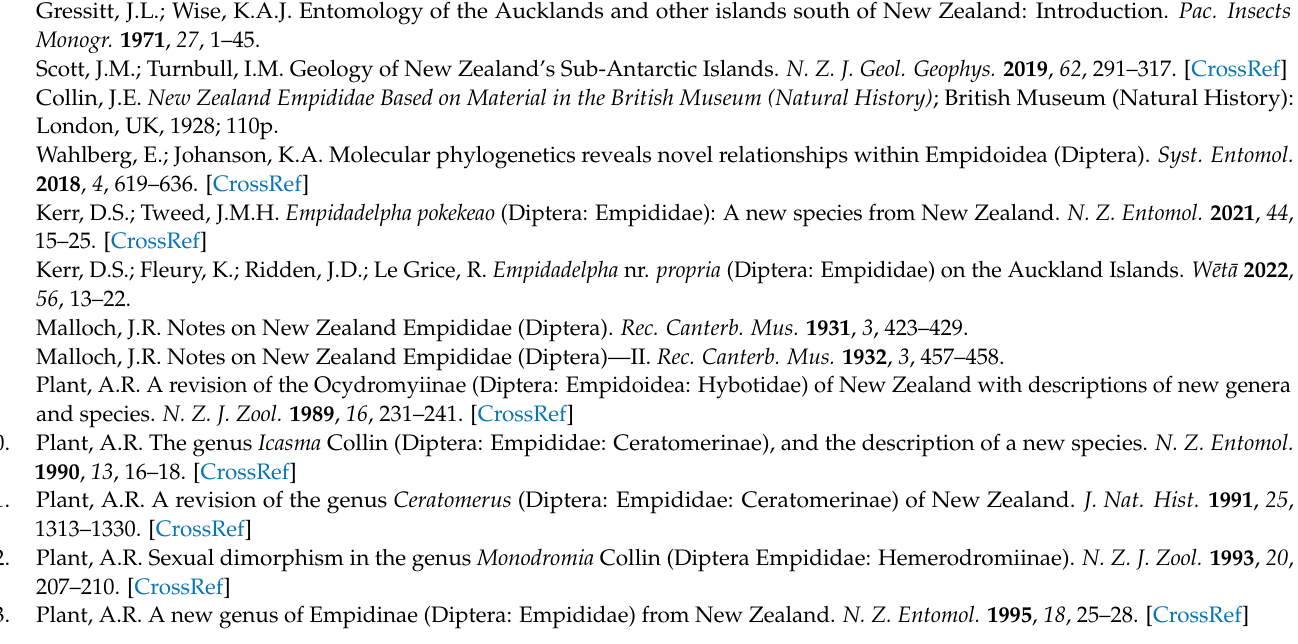
Figure 1. John Martin and Natalie Tees created the photoimaging. Neal Evenhuis, Keith Arakaki, and Jim Boone (BPBM) provided information, hospitality, and the loan of specimens. Natalie Tees constructed the plates in